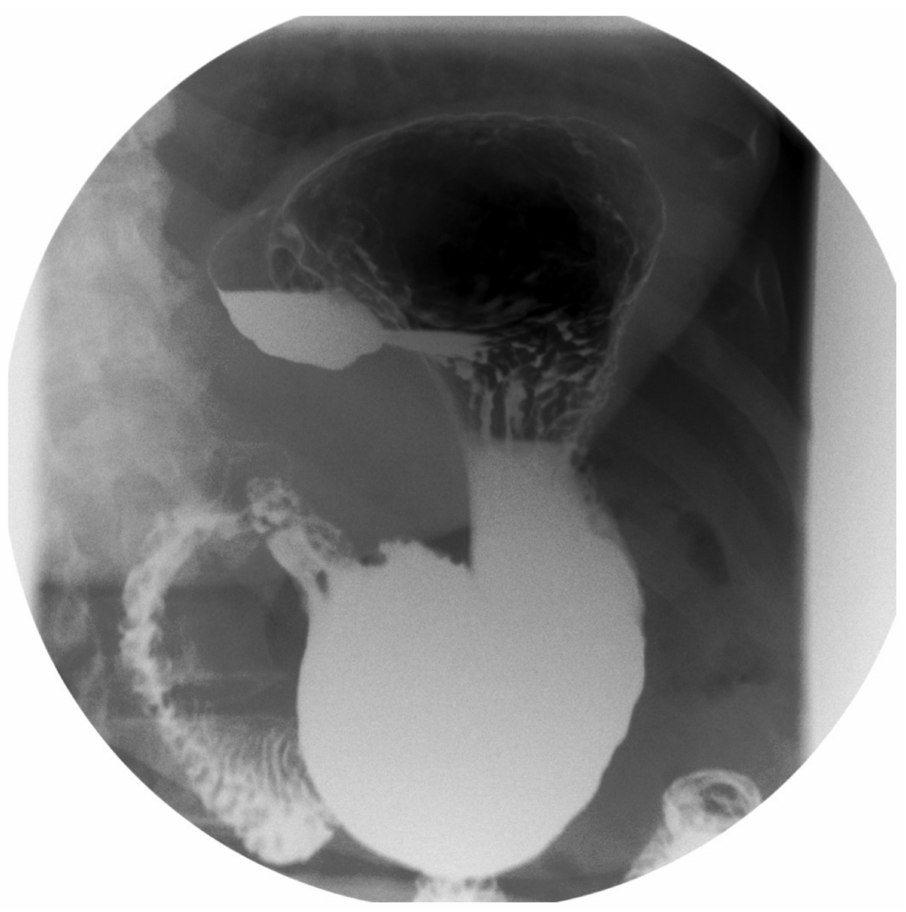
Figure 1. Preoperative upper gastrointestinal series showing diverticulum of the upper gastric